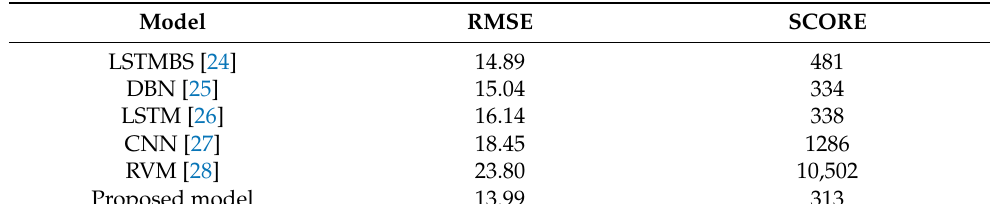
Table 12. Evaluation indexes for different models.